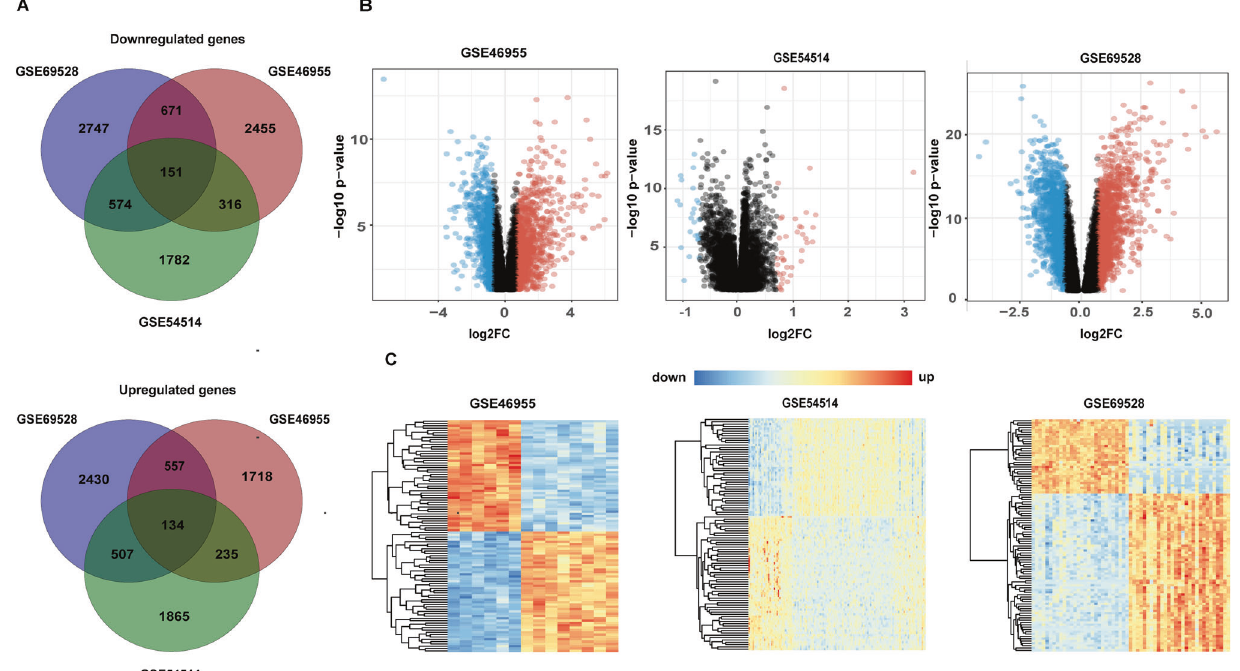
Fig. 2 Differential expression analysis of the GSE69528, GSE46955, and GSE54514 datasets. A Venn diagram showing the overlapping DEGs in the three datasets. B Volcano plot shows signi fi cantly differentially expressed genes in the three datasets. Red and blue plots represent upregulated and downregulated genes, respectively, with (|log2FC | >0.7 and P -value<0.05). Black plots represent the genes with no signi fi cant difference. C Heatmap of the top 100 DEGs in three datasets. Each row represents a DEG, and each column represents a sample. The color ratio indicates the relative level of DEG expression: blue, lower than reference expression; red, higher than reference